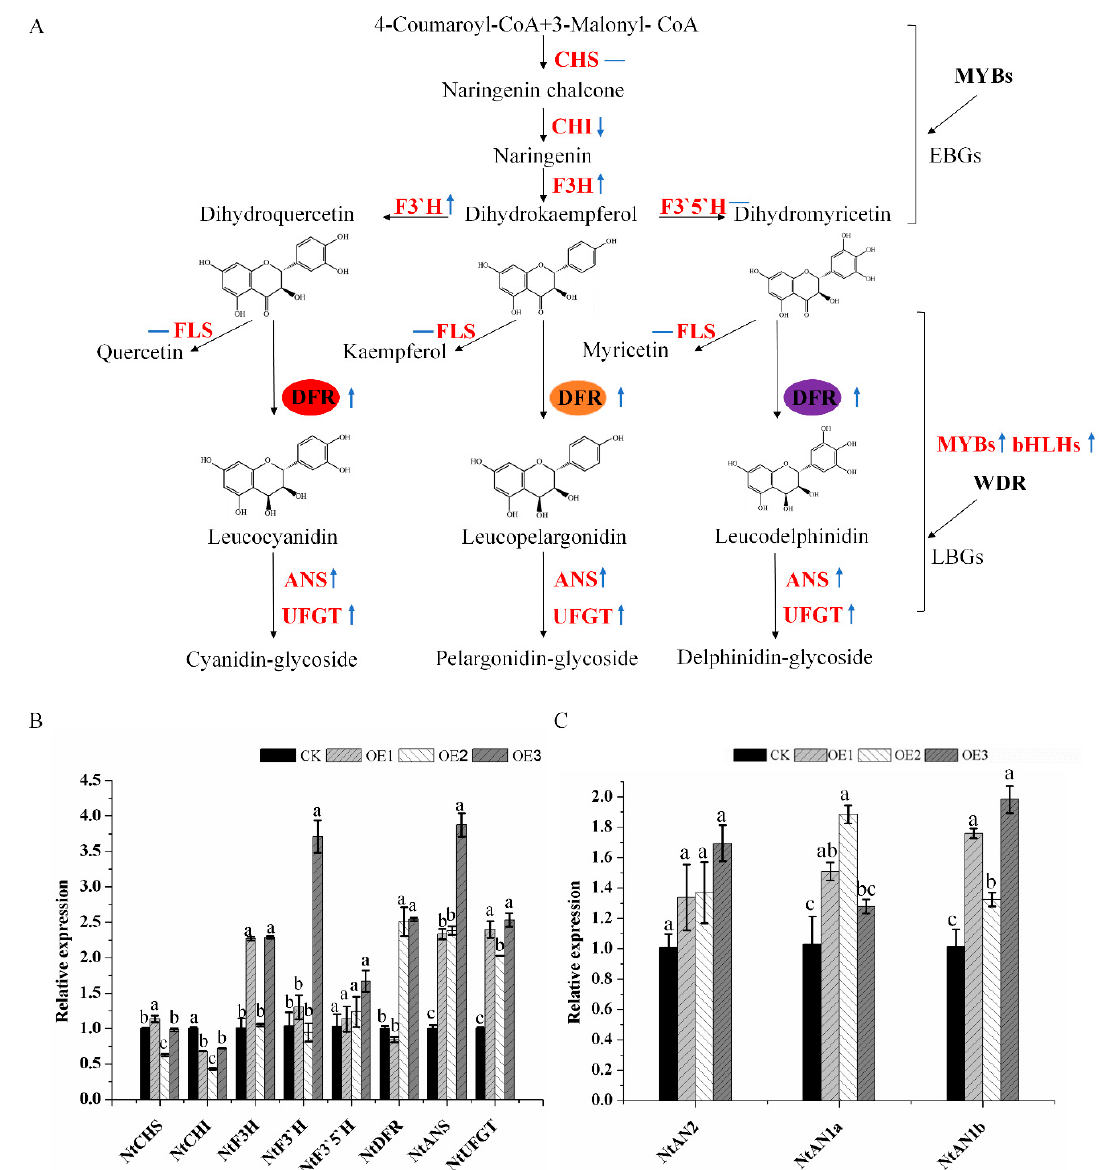
Figure 5. Schematic diagram of the flavonoid biosynthetic pathway leading to anthocyanins and expression profiles of anthocyanin biosynthetic endogenous genes in transgenic tobacco petals. ( A ). A schematic diagram of the flavonoid biosynthetic pathway, in which the dihydroflavonol reductase (DFR) catalyzes the NADPH-dependent reduction of dihydroflavonols to corresponding products. ( B ) Expression profiles of endogenous anthocyanin biosynthetic genes in petals of the CK line and MaDFR OE lines (OE1–3). Expression patterns in petals of the early biosynthetic genes ( NtCHS , NtCHI , F3H , NtF3’H and NtF3’5’H ) and the late biosynthetic genes ( NtDFR , NtANS , and NtUFGT ). ( C ) Expression patterns in petals of the regulatory genes (NtAN2 , NtAN1a , and NtAN1b ). Data represent means ± SEs of three independent experiments. Values which are not significantly different among samples are identified by the same letter (a–c). Abbreviations used are: CHS: chalcone synthase, CHI: chalconeisomerase, F3H: flavanone 3-hydroxylase, F3 ′ H: flavonoid 3 ′ -hydroxylase, F3 ′ 5 ′ H: flavonoid 3 ′ 5 ′ -hydroxylase, DFR: dihydroflavonol 4-reductase, ANS: anthocyanidin synthase, UFGT: anthocyanidin 3- O -glucosyltransferase, MYBs: MYB transcription factors, bHLHs: basic helix-loop-helix proteins, WDR: WD repeat protein, EBGs: early biosynthetic genes, LBGs: late biosynthetic genes. The analyzed genes are highlighted in red. The upward blue arrow represents the upregulation of the gene, the downward blue arrow represents the downregulation of the gene, and the horizontal blue line represents a slight change in gene